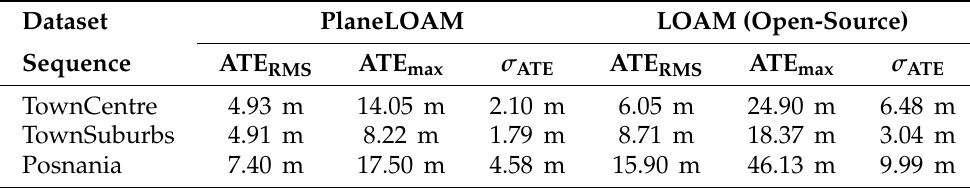
Figure 19. Results of experiments in localization of a city bus equipped with a single Sick MRS-6124 LiDAR ( A ). The two sequences, denoted TownCentre ( C , D ) and TownSuburbs ( E , F ) were acquired in a moderately structured environment of a small town ( B ). The trajectories estimated by PlaneLOAM are closer to the ground truth than their counterparts obtained from the open-source LOAM ( C , E ), while the ATE values for PlaneLOAM trajectories are much smaller ( D , F ). Table 2. Comparison of ATE errors for sequences recorded with a Sick MRS-6124